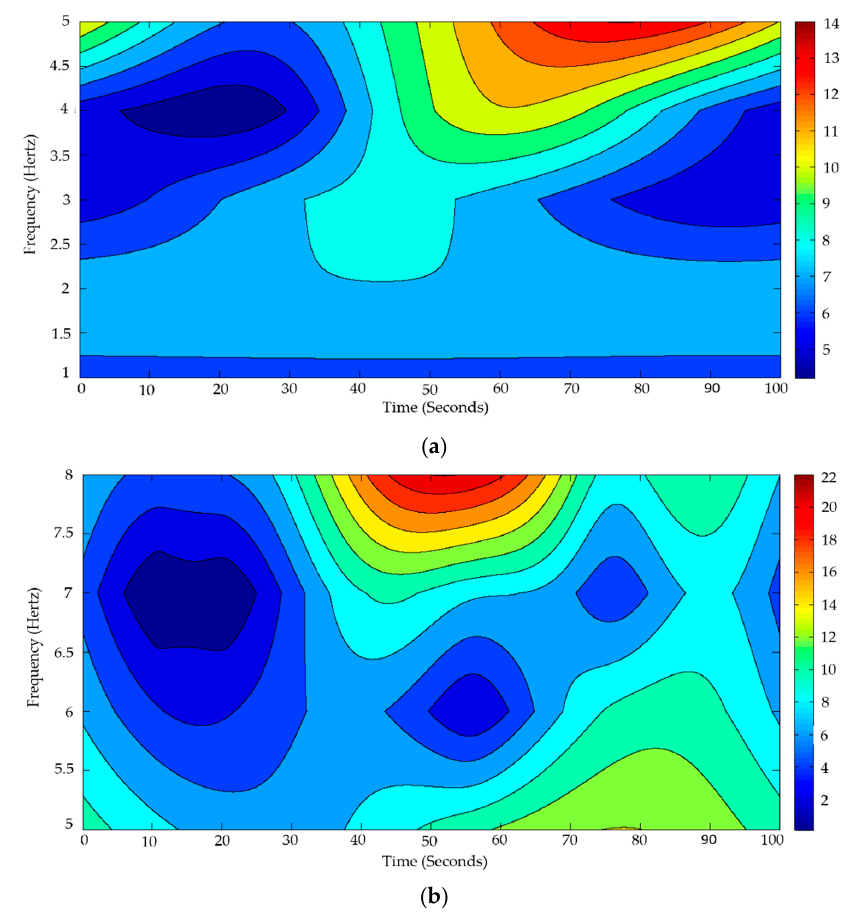
Figure 6. Stockwell transform spectrograms of the EEG signal of Subject 3: ( a ) frequency range of 1–5 Hz; and ( b ) frequency range of 5–8 Hz. 1–5 Hz; and ( b ) frequency range of 5–8